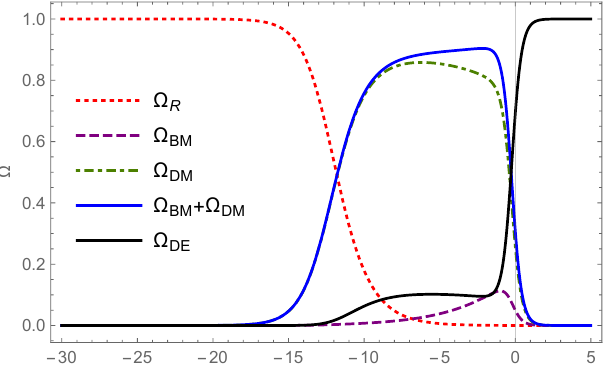
Figure 3. Evolution of the density parameters of radiation, baryonic and dark matter, and dark energy for λ = 0 (similar to the case λ = 4). The transition to a matter-dominated universe occurs much earlier than in the case λ = 2, but still after the primordial nucleosynthesis epoch. Contrarily to the case λ = 2, the peaks of Ω BM and Ω DM do not occur simultaneously. During the matter-dominated era, the energy density of dark energy is already a noticeable fraction of the total energy density. At the present time u 0 = 0 the density parameters are Ω DE 0 = 0.69, Ω DM 0 = 0.26, Ω BM 0 = 0.05, and Ω R 0 = 5 × 10 − 5